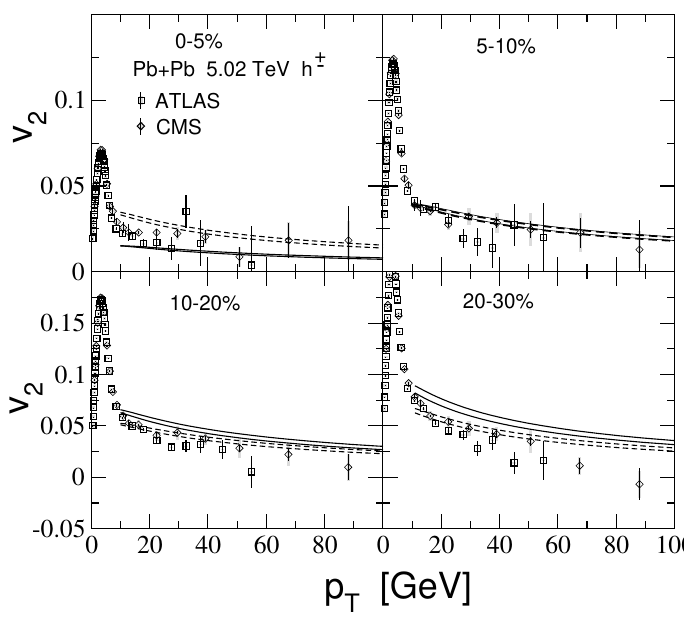
√ Figure 9 . Same as in figure 8 for s = 5 . 02 TeV. The parameters are the same as for figure 5. Data points are from ATLAS [88] and CMS